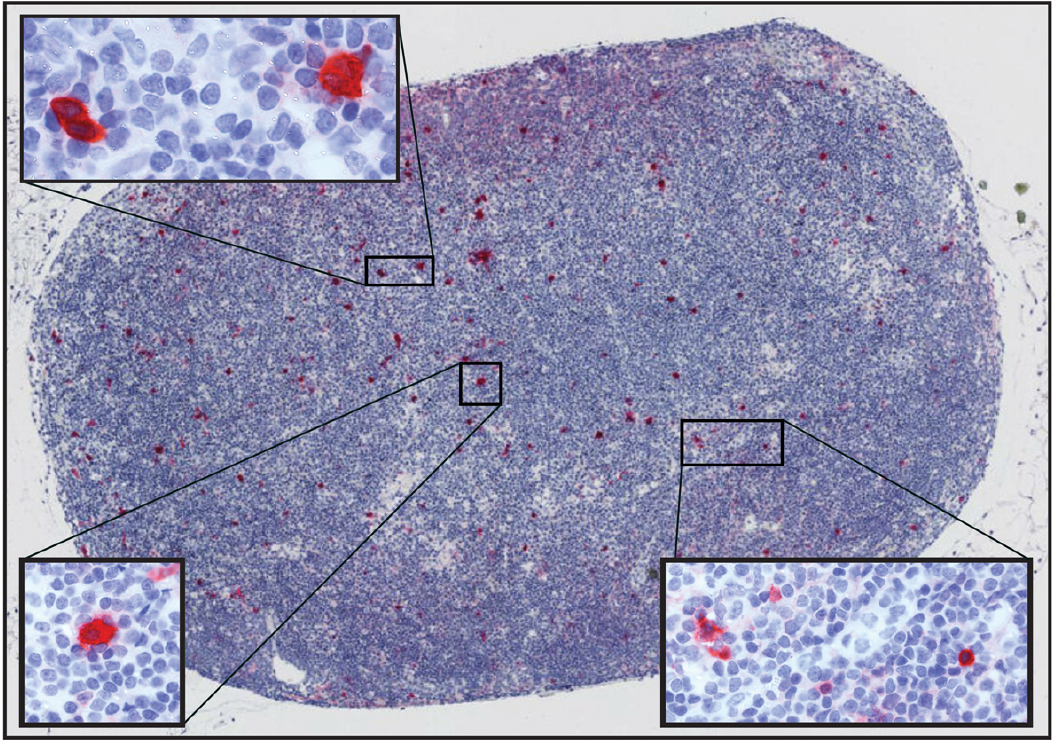
Figure 8: Human cells expressing p24 (dark red) in the lymph node of an HIV-infected NSG mouse. The amplified image at the top left corner shows multi-nucleated giant cells, i.e., infected T cells that fuse with each other inducing syncytia. The lower left image shows a single HIV-infected macrophage. The lower right image depicts HIV-infected T cells among other HIV-infected